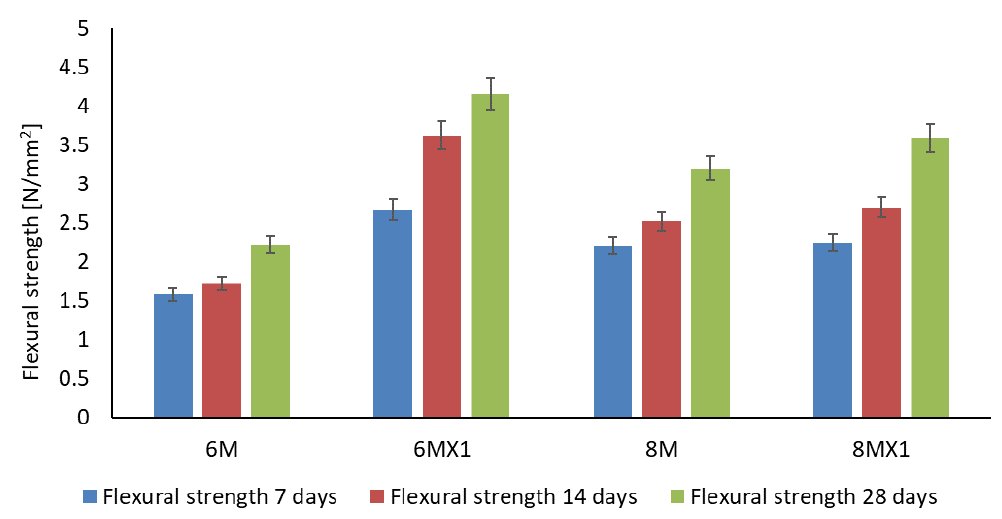
Figure 2. Flexural strength of the alkali-activated geopolymer samples.